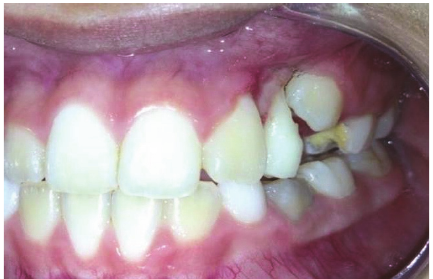
Figure 5: Seven-day control.